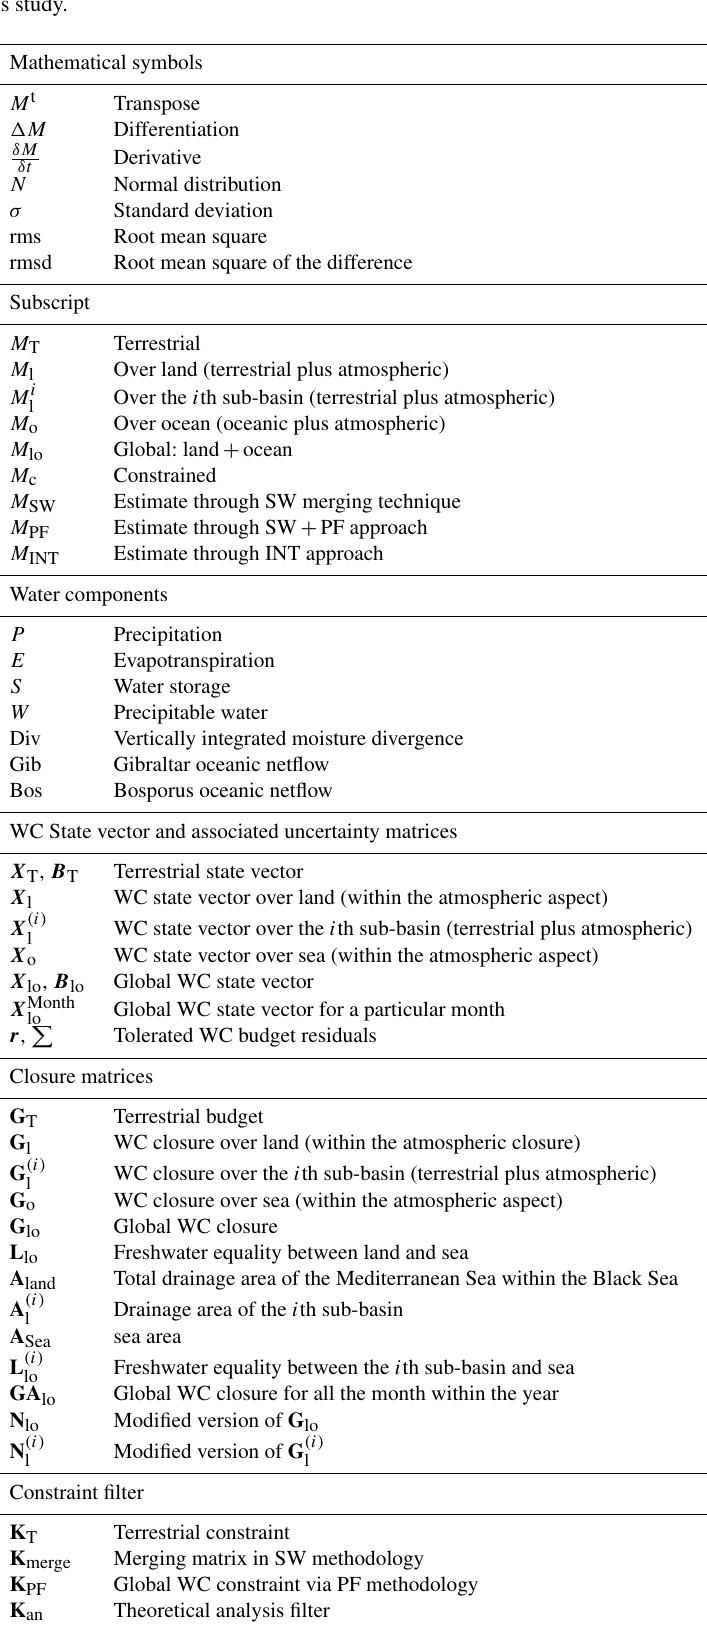
Table A1. Notation used in this